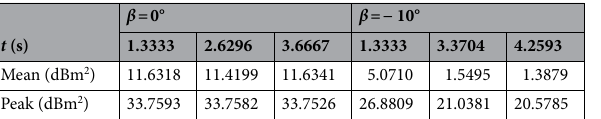
Table 10. RCS indicator of the aircraft in Z4 mode, α = 0° ~ 360°, f RH = 6 GHz, ω m1 = ω m2 = 0.1963